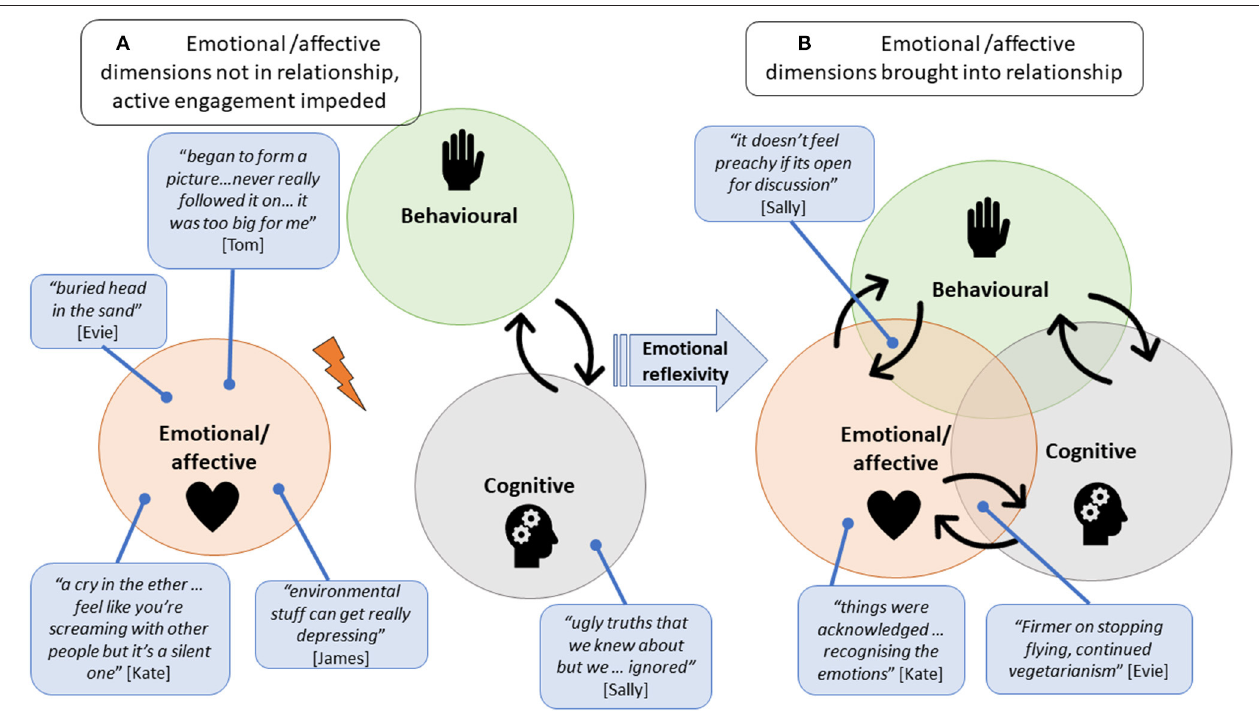
FIGURE 2 | (A,B) Development of emotional reflexivity for push factors of workplace and those motivated by seeking community. Symbols: Heart: emotional/affective dimensions; Head: cognitive dimensions; Hands: behavioral dimensions; Arrows: feedback between the dimensions; Blue speech bubbles: quotes from participants; Tension between the dimensions; Process of participation in the CLP or